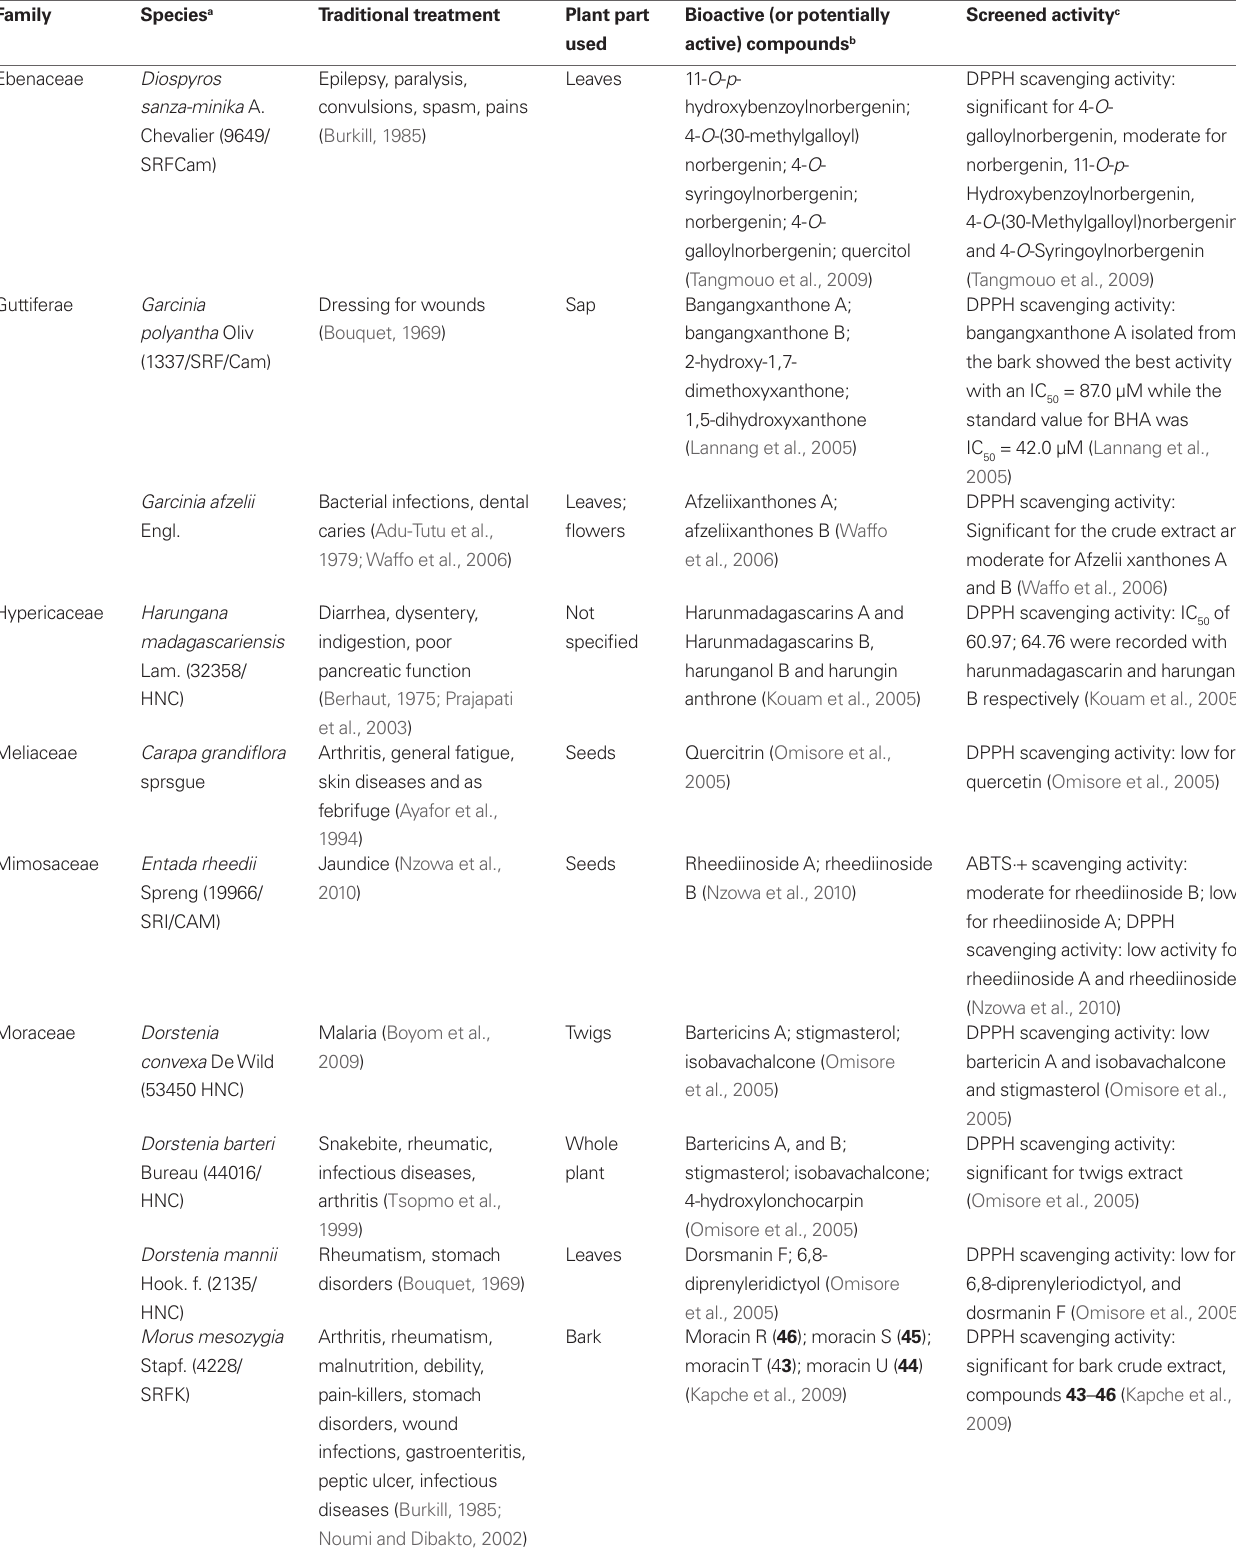
Table 6 | Plants used in Cameroon with evidence of their as antioxidant